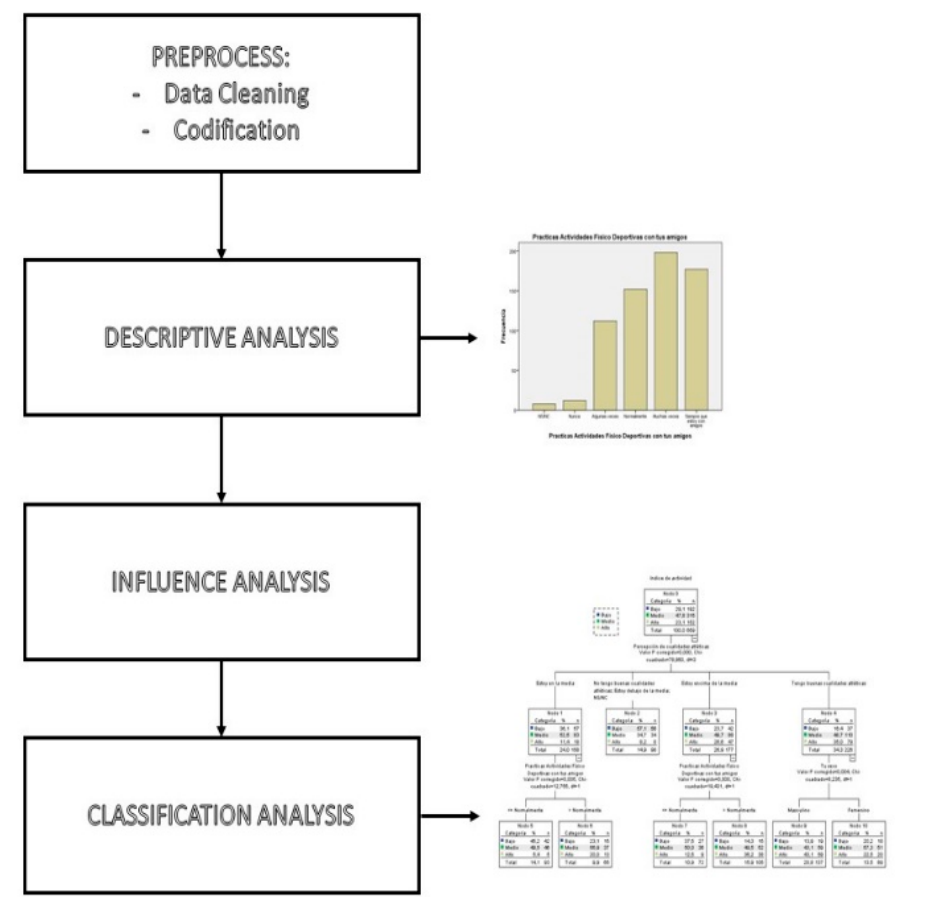
Figure 1. Diagram of the data analysis